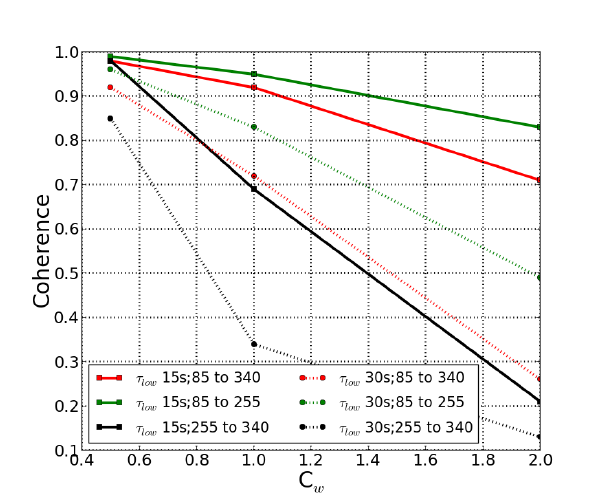
Figure 4. Expectations for FPT Coherence at 10 min integration time for a range of weather condi- tions (Very Good to Tolerable). Different colors are for all combinations of frequency pairs: green and red for pairs with 85 GHz as the reference frequency (i.e., 85 → 255 and 85 → 340, respectively) and black for 255 GHz as the reference frequency (i.e., 255 → 340). Solid and dashed lines are for calibration timescales at the low frequency equal to 15 s and 30 s, respectively. Higher